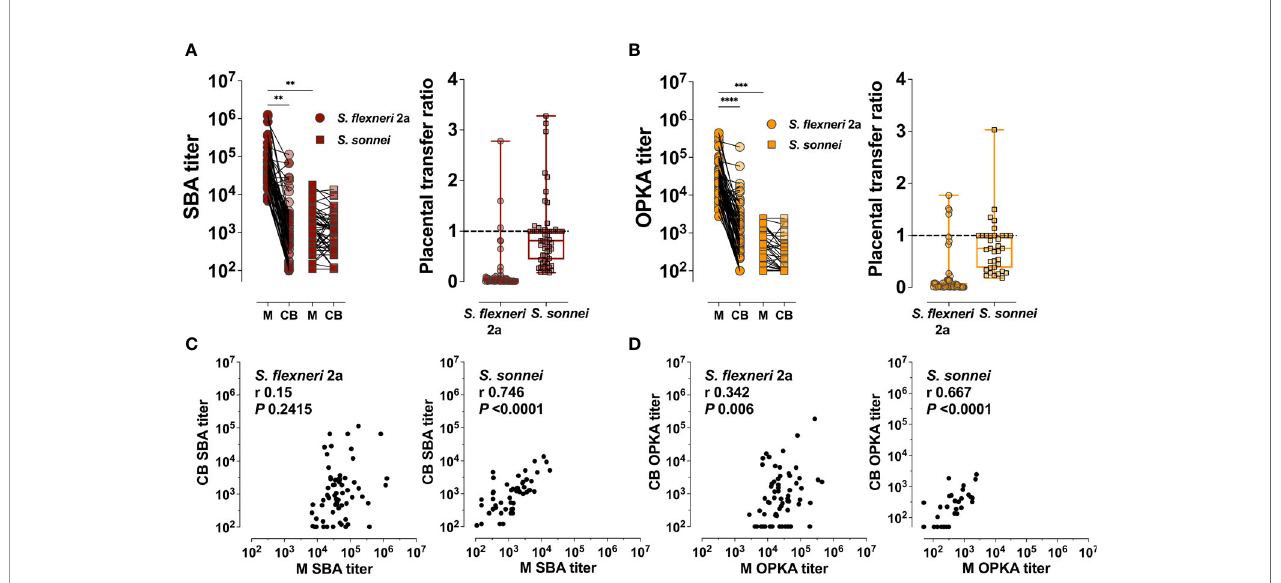
FIGURE 4 | Maternal and placentally-acquired infant functional antibodies against Shigella . (A) Serum bactericidal antibody (SBA) and (B) opsonophagocytic killing antibody (OPKA) titers measured in maternal (M) and cord blood (CB) sera (left graphs). Data represent individual titers. Placental transfer ratios (cord blood titer/ maternal titer) for each dyad are shown on the right. Asterisks indicate statistically signi fi cant differences as determined by one-way ANOVA with a Tukey ’ s post-test correction; ** P < 0.01, *** P < 0.001, **** P < 0.0001. Whiskers indicate minimum and maximum values. Line is at ratio = 1. (C, D) Associations between maternal (M) and cord blood (CB) SBA and OPKA titers, respectively. Pearson ’ s r and P values are shown within each graph.